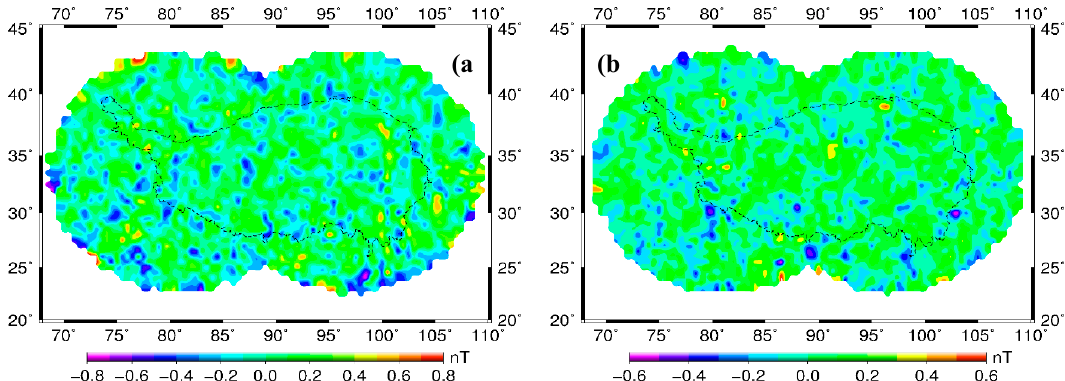
Figure 6. Contour maps of difference for Z component between R-SCHA model and satellite observation. ( a ) CHAMP satellite observation at 330 ± 5 km; ( b ) Swarm satellite observation at 470 ± 5 km.